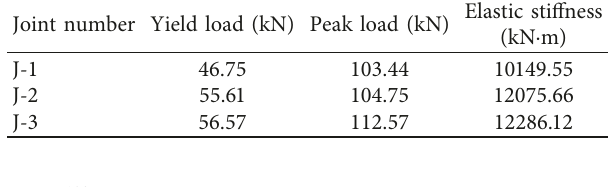
Table 3: Comparison of load bearing behavior.